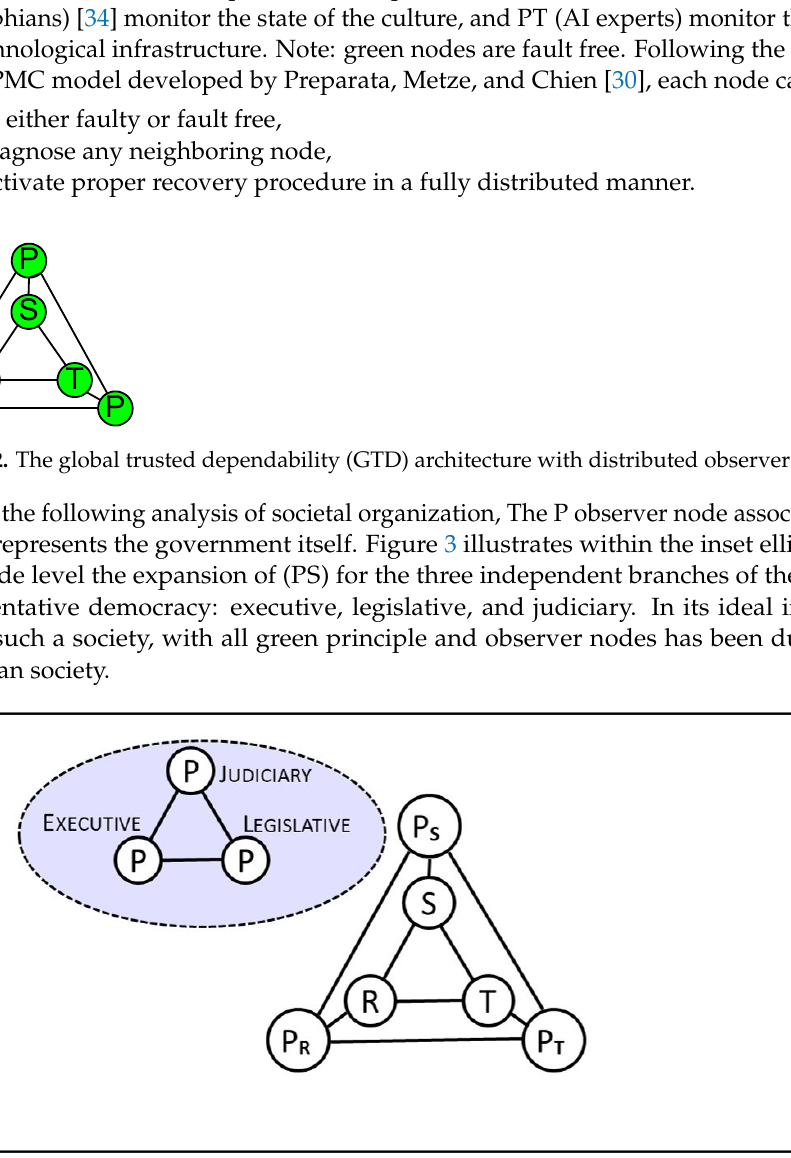
Figure 3. The Vitruvian society as a Preparata, Metze, and Chien (PMC) model.